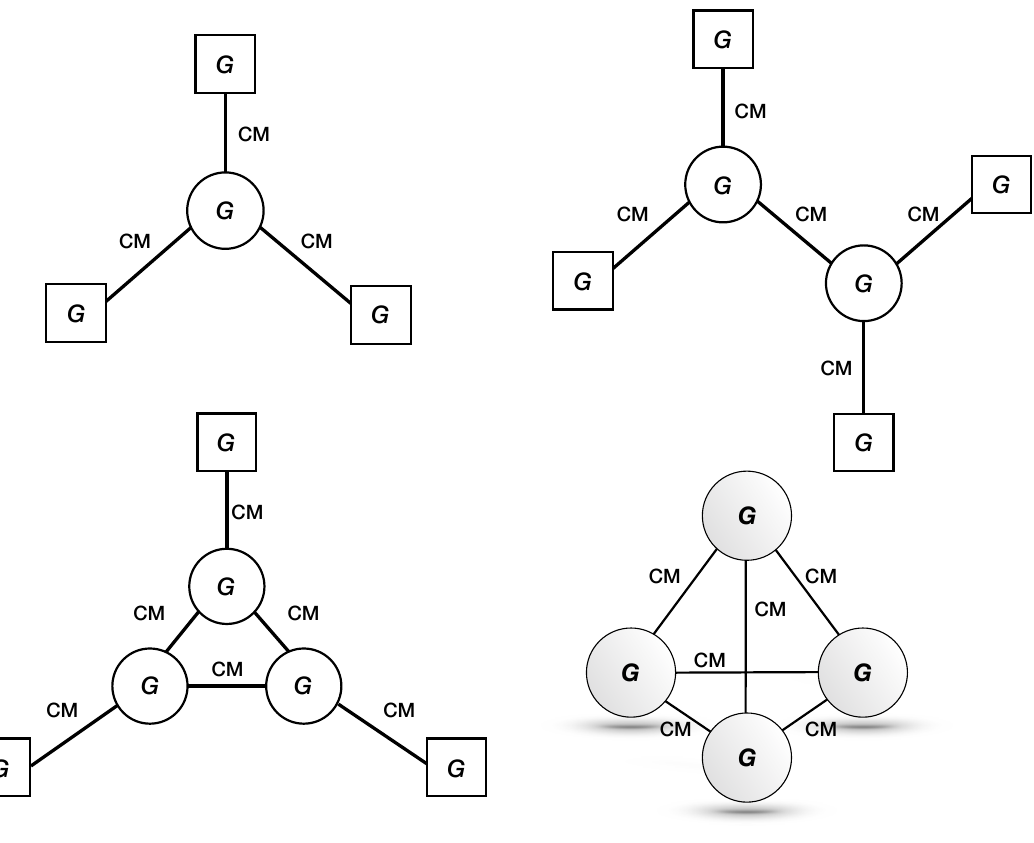
Figure 1 . Examples of quiver gauge theories with conformal matter. Here, each line with \CM" indicates 4D N = 2 G (cid:2) G conformal matter, namely 6D G (cid:2) G conformal matter compacti(cid:12)ed on a T 2